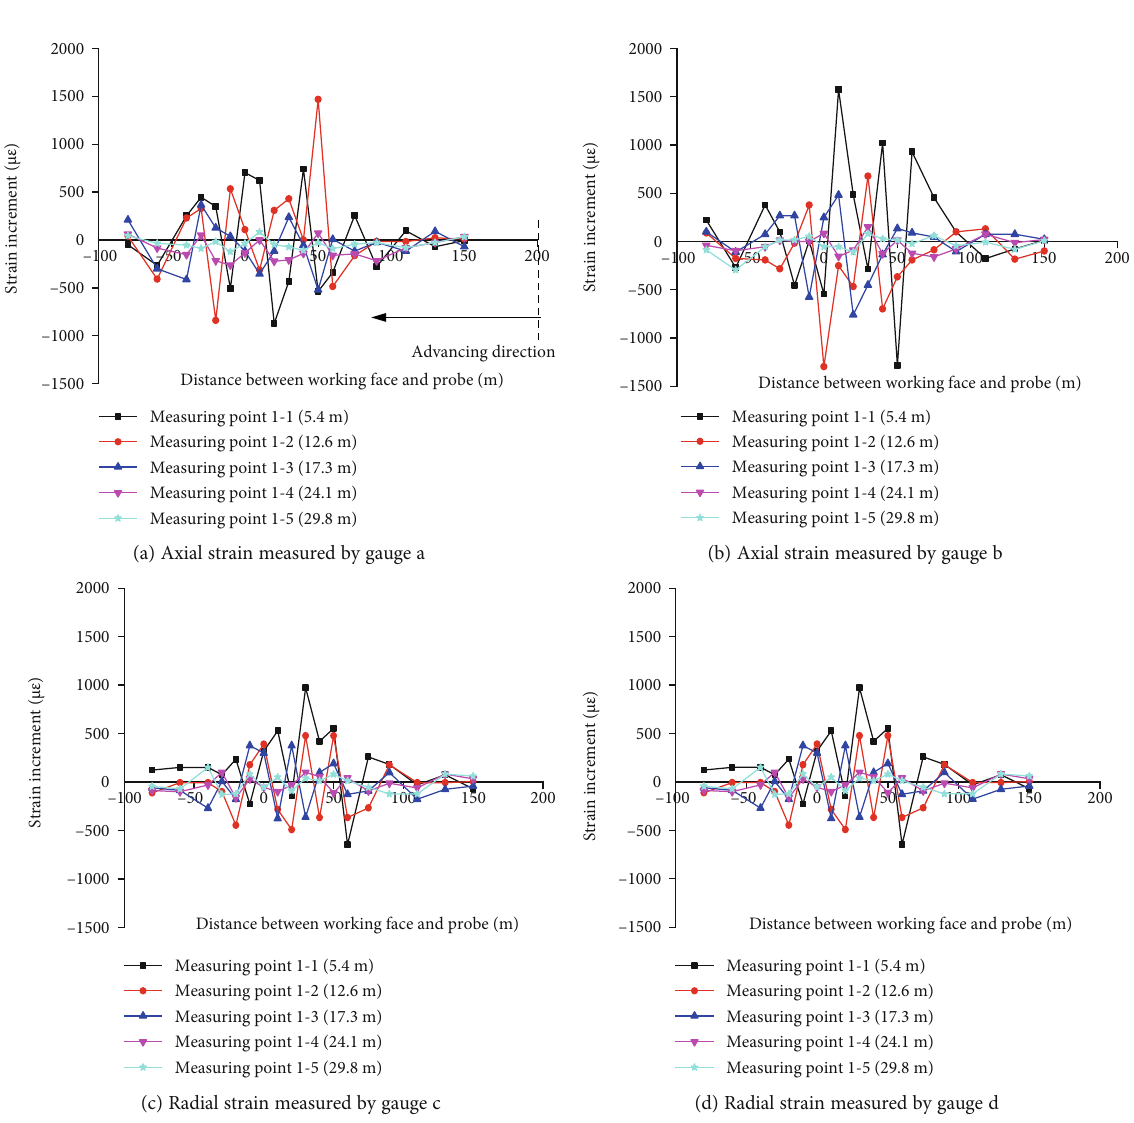
Figure 5: The increment of axial strain and radial strain of the No. 1